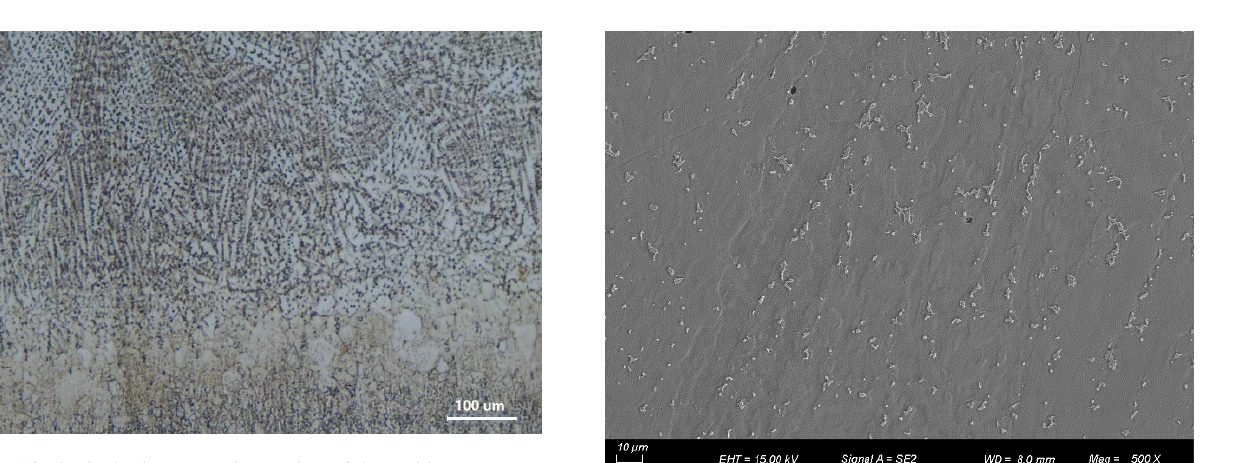
Figure 16. Optical microscope inspection of the weld seam.